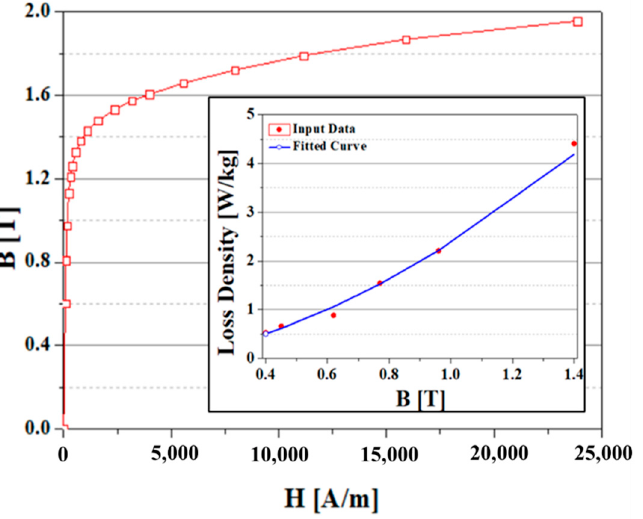
Figure 10. B–H curve of non-oriented silicon steel in the simulation model. Inset: iron loss proper- ties.